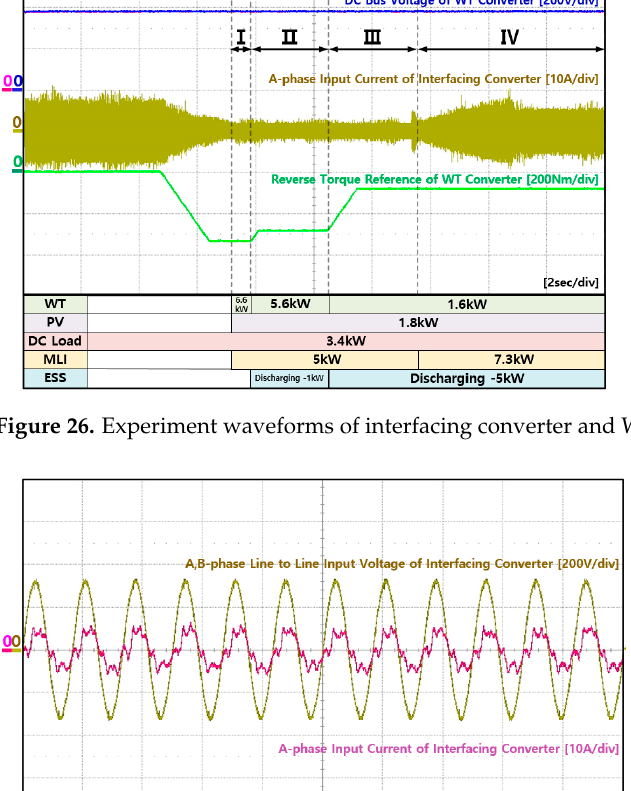
Figure 27. Experiment waveforms of interfacing converter at AC grid in mode 5.